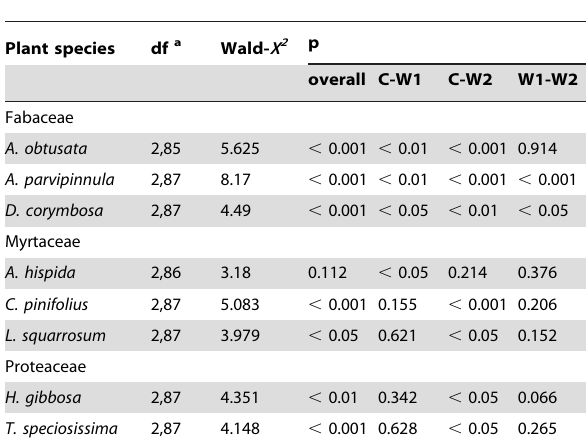
Table 2. Summary statistics for multivariate generalised linear model analyses (mGLM) of feeding guild species richness data, for the entire Coleoptera and Hemiptera guild structure.